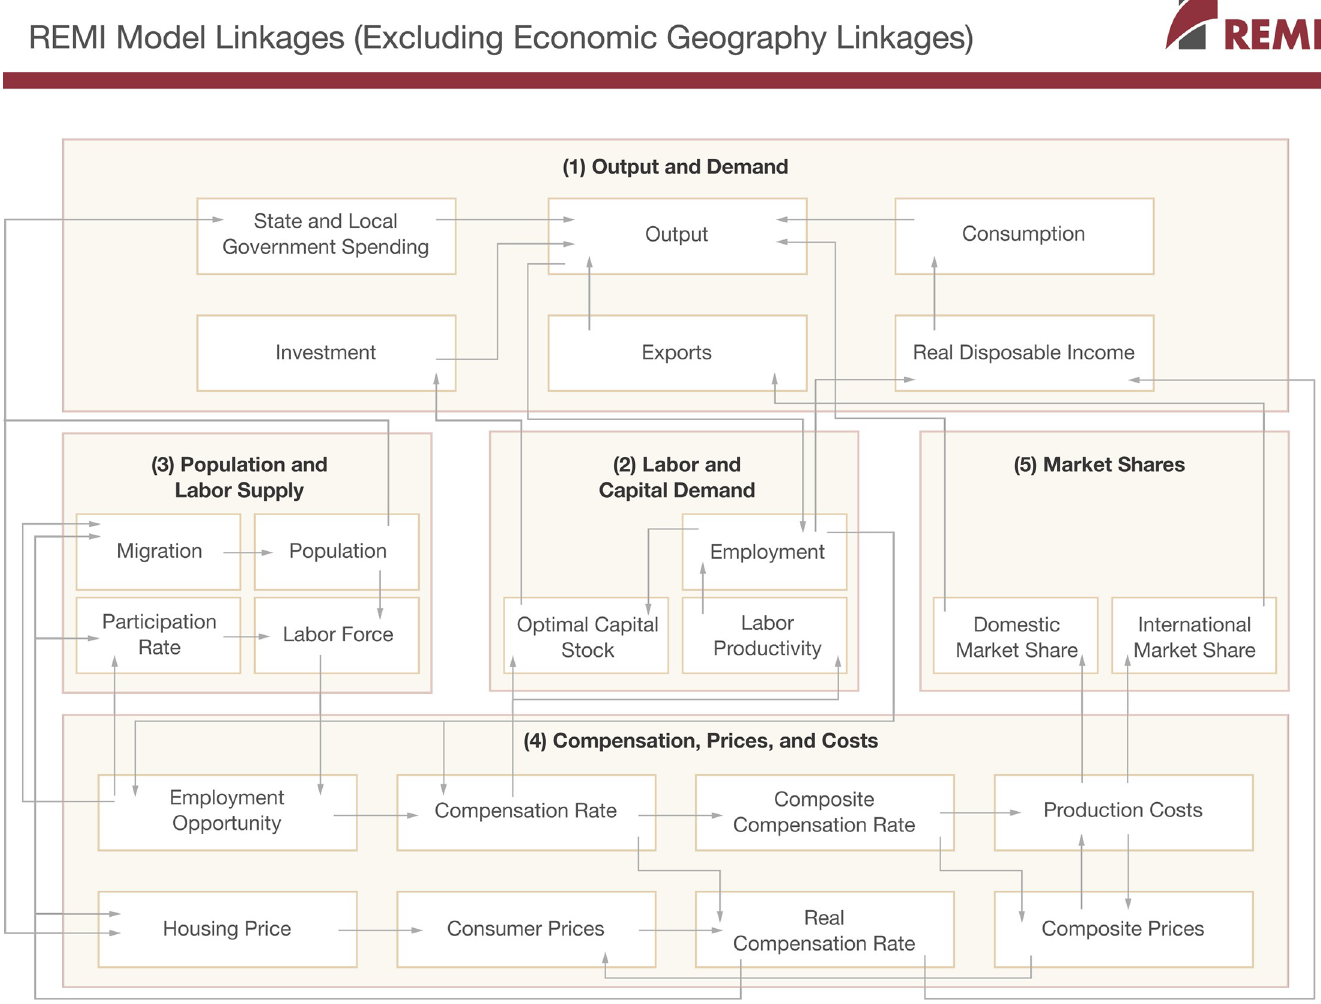
Fig 1. The REMI structural economic forecasting